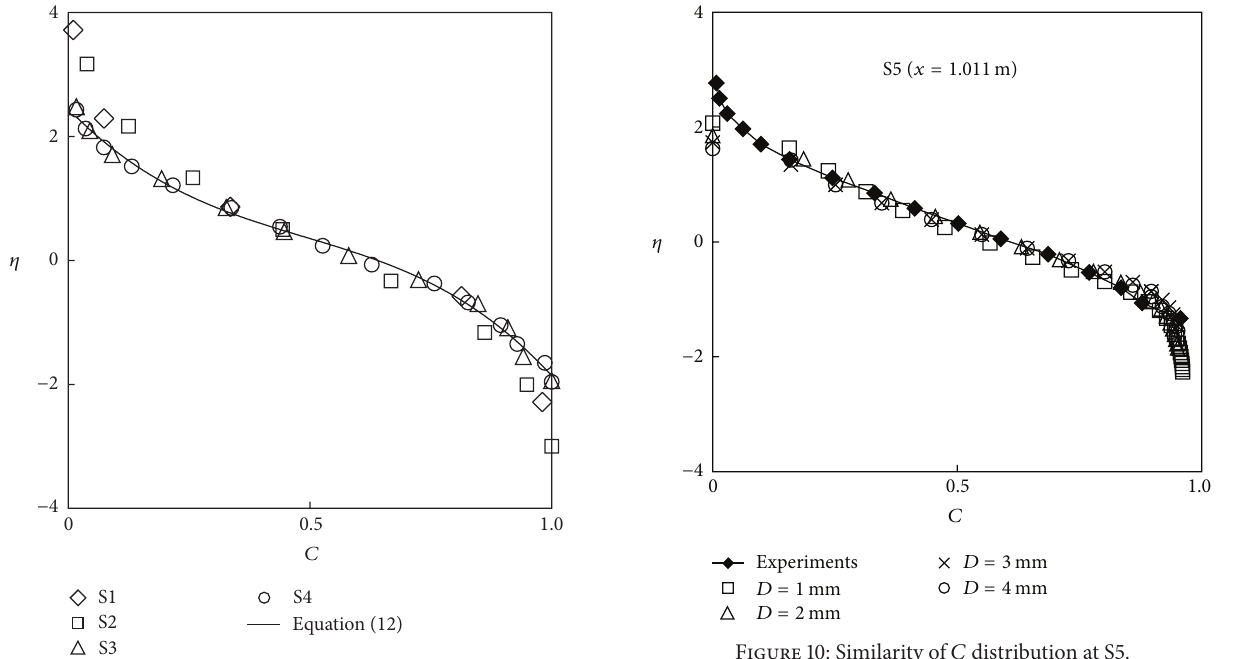
Figure 8: Similarity of 𝐶 distributions for experiments.